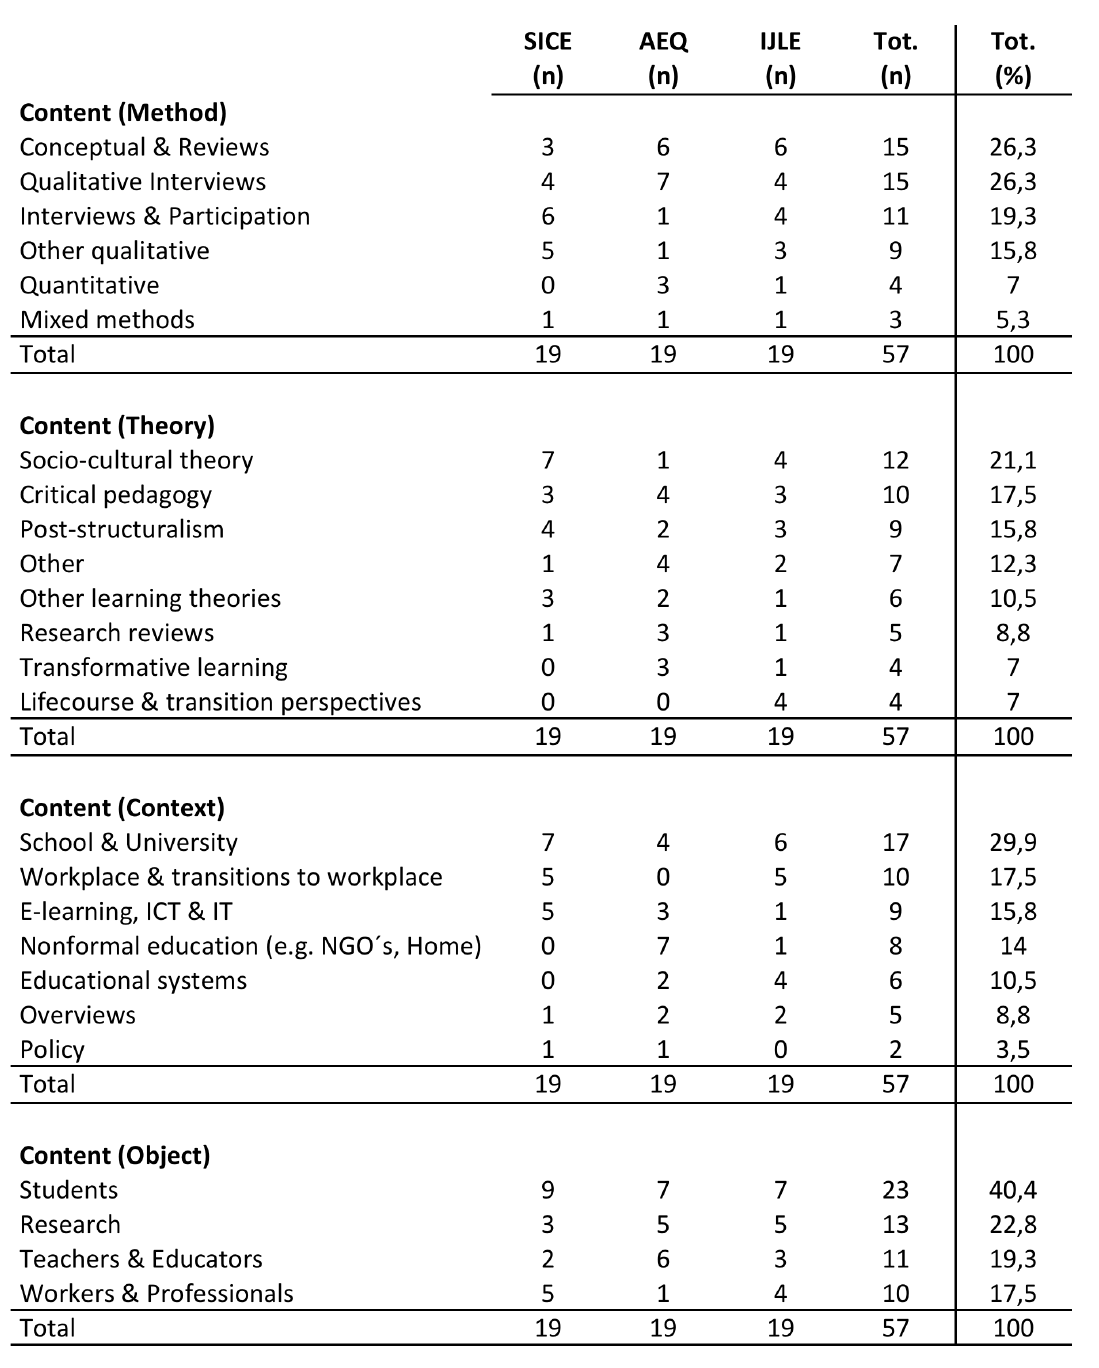
Table 2. Number and share of top-cited articles in three adult educational journals, categories related to